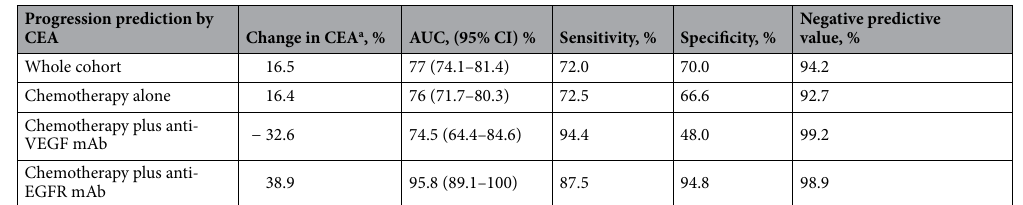
Table 2. Prediction of progression by the percentage change in the serum carcinoembryonic antigen (CEA) level at the time of the first response evaluation in patients treated with chemotherapy alone or chemotherapy plus anti-vascular endothelial growth factor (VEGF) or anti-epidermal growth factor receptor (EGFR) monoclonal antibody (mAb). AUC, area under the curve; mAb, monoclonal antibody. a Change in CEA = (CEA at 1st evaluation—baseline CEA)/baseline CEA.